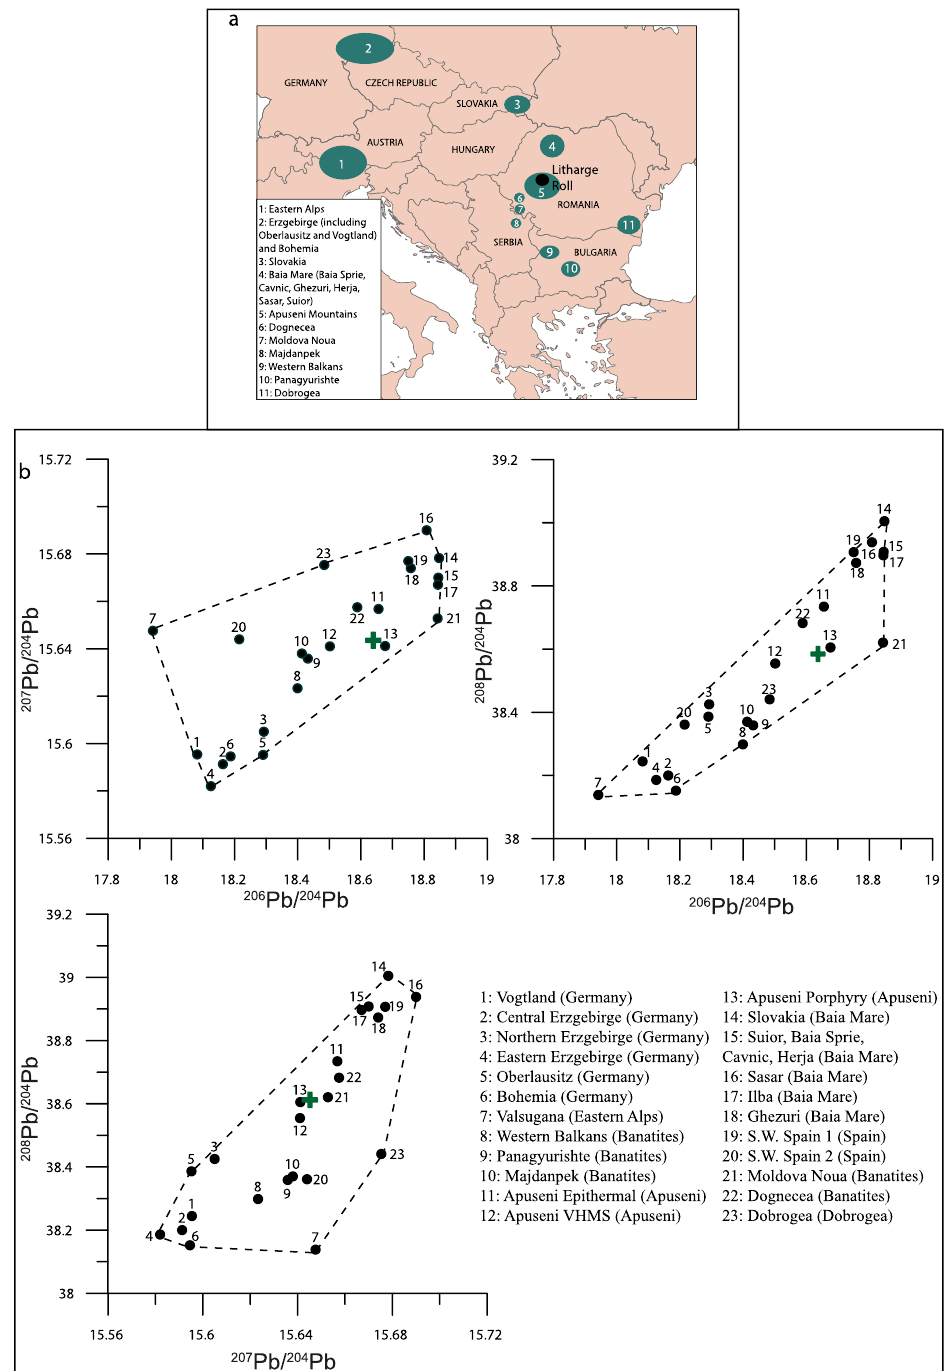
Figure 6. ( a ) Map of eastern Europe outlining the location of the Romanian artefact (Litharge roll, black circle). Also displayed are all mining regions modelled to understand the provenance of the Pb within the artefact. ( b ) displays convex hulls for modelling the litharge roll, Romania. As before, black circles reflect the sources used to reconstruct possible sources of Pb, whilst the green cross indicates the isotope composition of the modelled